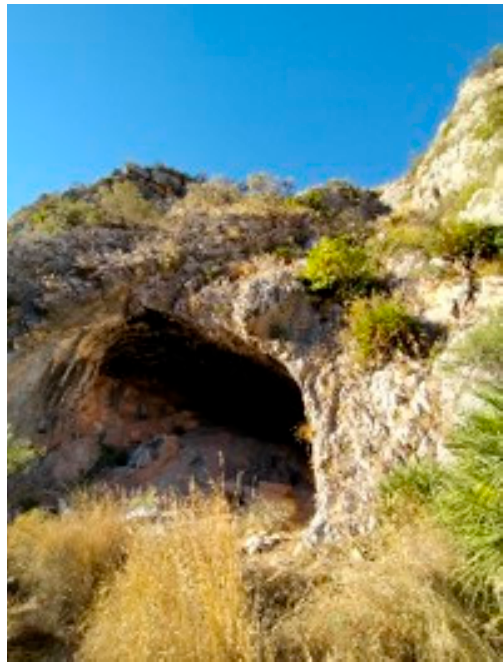
Figure 8. Above the shelter cave, the line of the mountain is concave. Photo of the author.